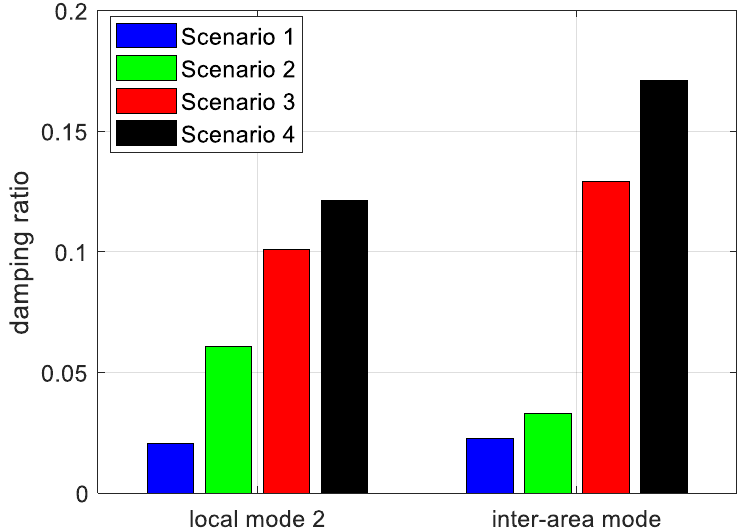
Figure 5. Damping performance comparison under different scenarios.